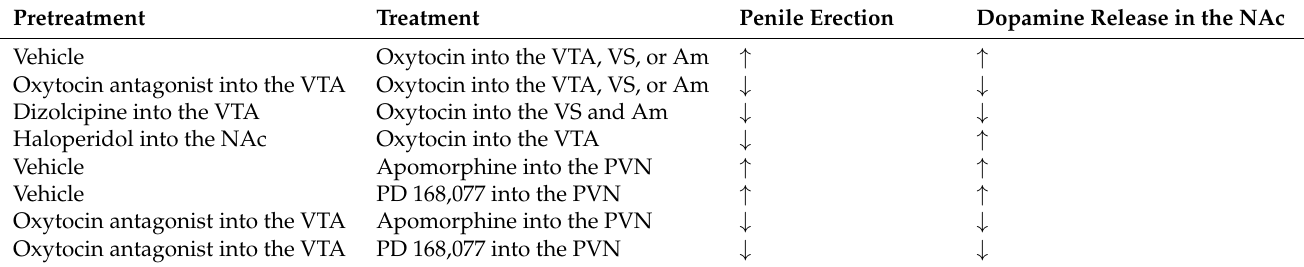
Table 7. Dopamine released in the nucleus accumbens plays a role in penile erection induced either by oxytocin given to the ventral tegmental area, the ventral hippocampus and the amygdala or by D 2 and D 4 dopamine receptor agonists given to the